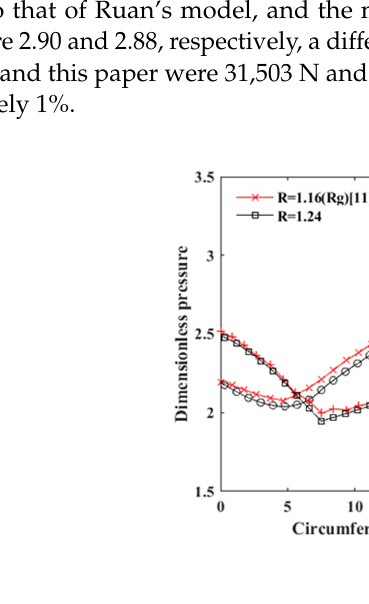
Figure 3. Comparison of pressure distribution with Wang’s result ( a ); and Ruan’s result ( b ).